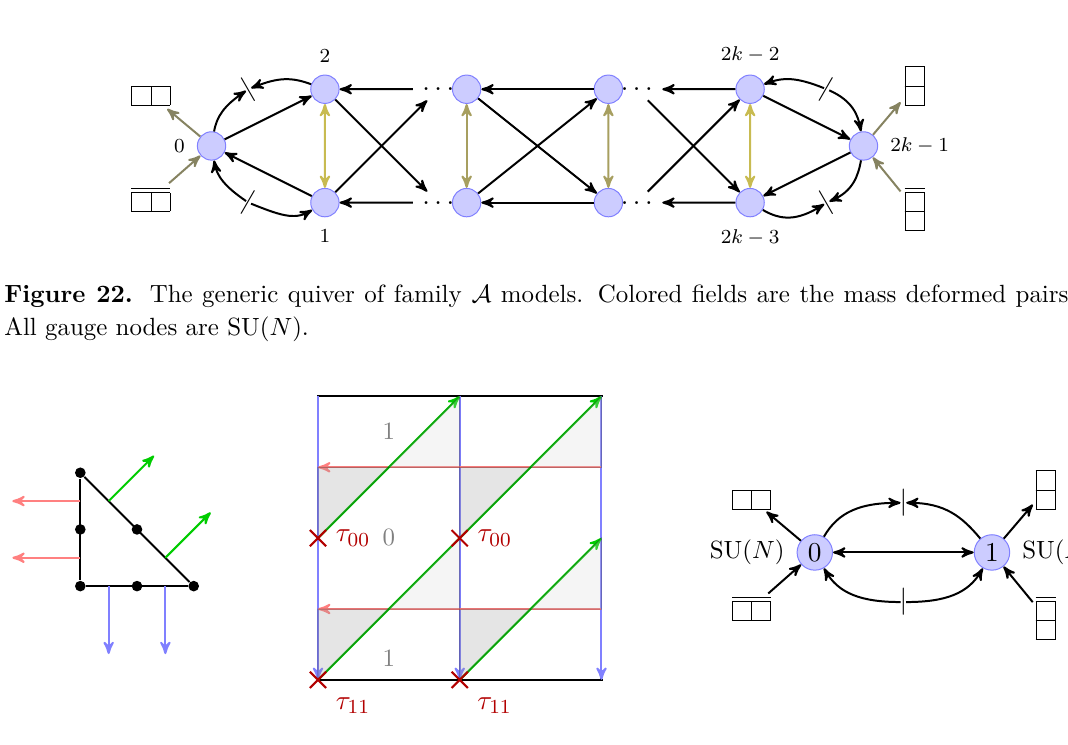
Figure 23. The model L 0 , 2 , 0 / Z 2 . On the left the toric diagram is drawn, at the center the five- brane and its orientifold projection with fixed points, on the right the quiver resulting from the orientifold